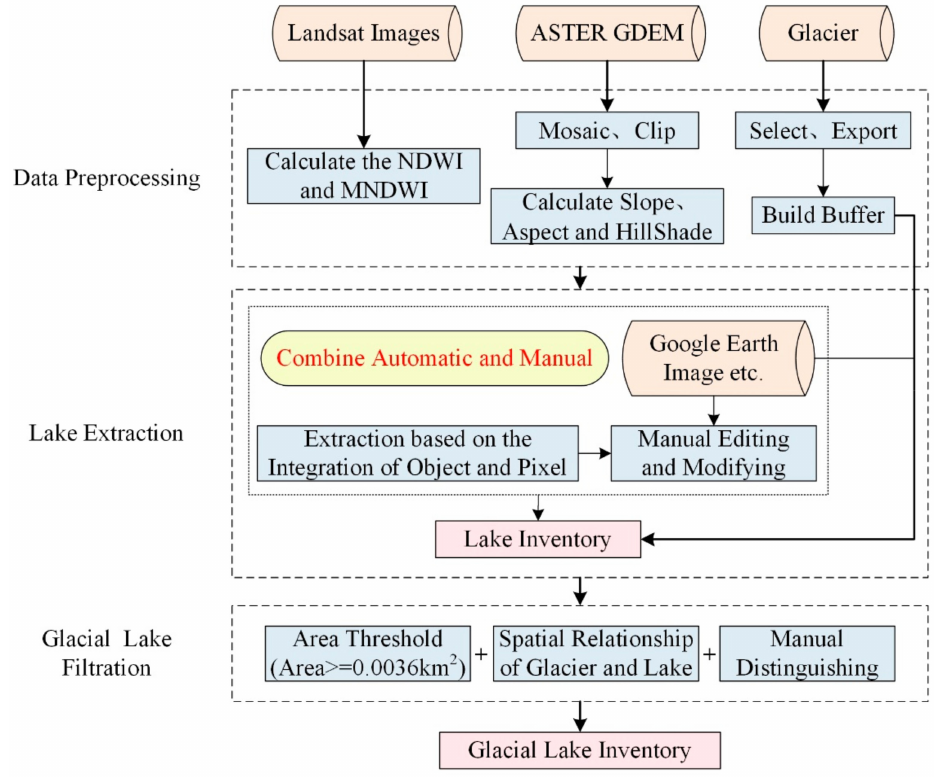
Figure 2. Flow chart of glacial lake extraction process utilized in this